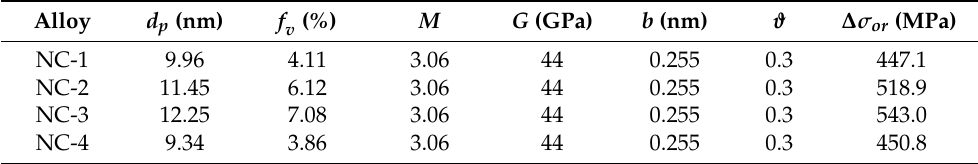
Table 2. Relevant parameters and theoretical values of the precipitation strengthening.